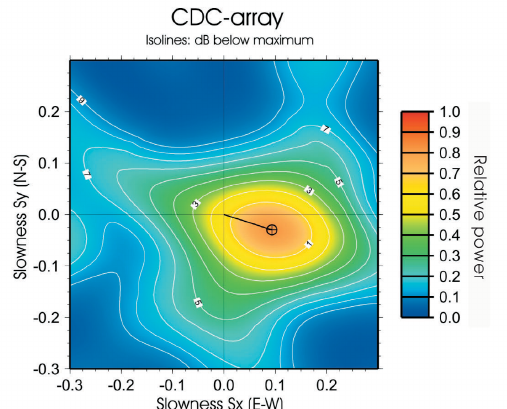
Fig. 8. F - k analysis based on the nine bandpass fil- tered (2.0-4.0 Hz) vertical seismograms of the local seismic event plotted in fig. 7. Maximum energy (rel- ative power=0.86) is found for an apparent velocity of 10.0 km/s in a backazimuth of